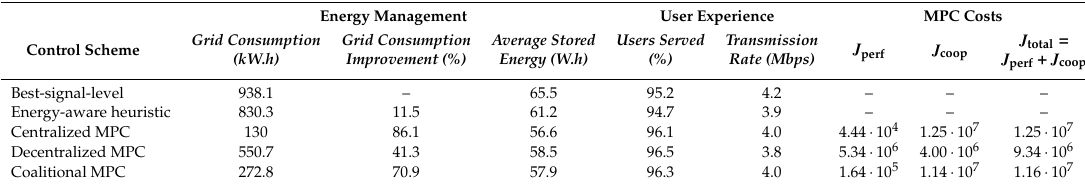
Table 2. Numerical results in the 9-BS network.